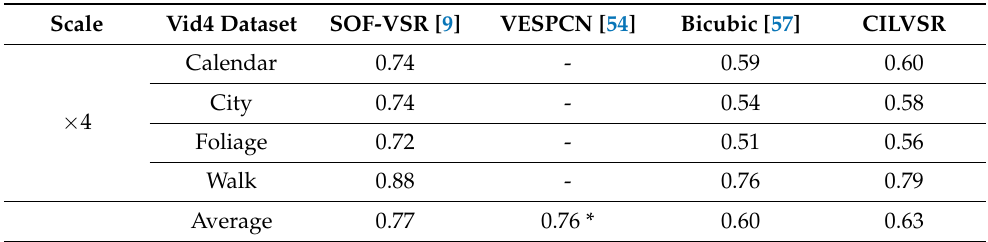
Table 7. Comparative result of SSIM value of proposed method and other technique. The results marked with an asterisk (*) are sourced from the respective